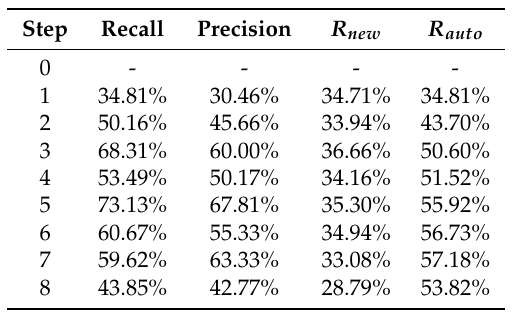
Table 4. Recall, Precision, RS updating rate and automatic transcription rate evaluated step by step for the tool equipped with the KWS system.